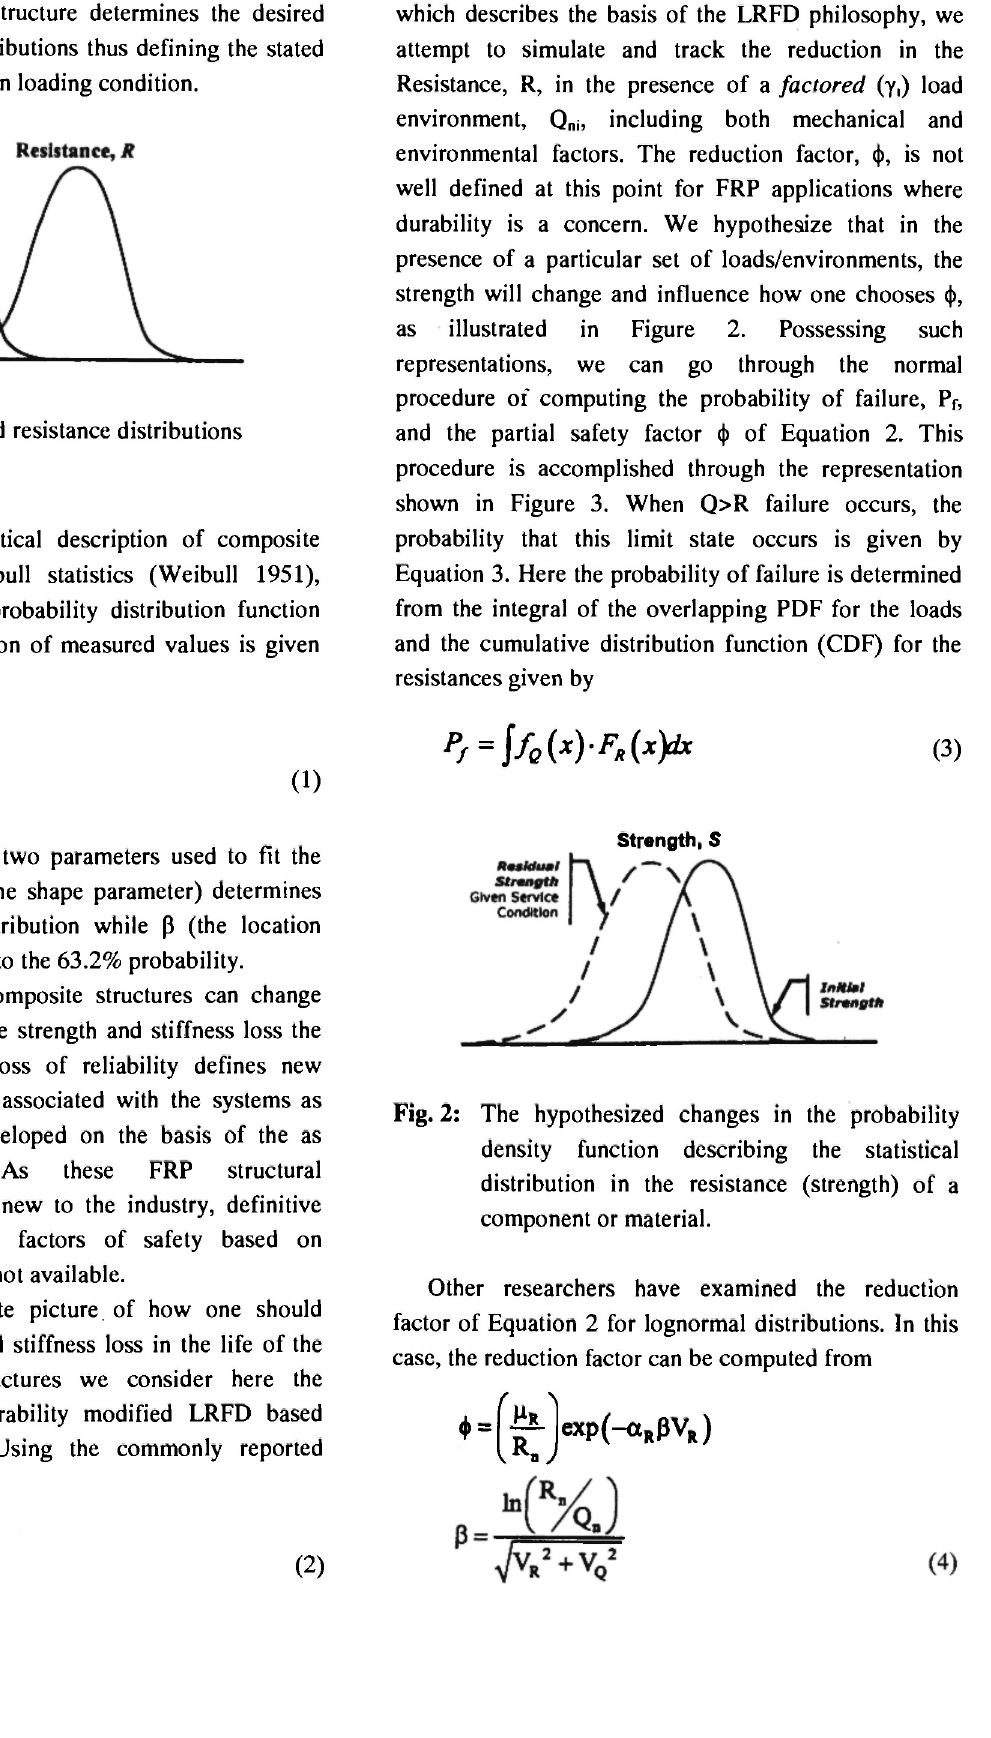
Fig. 1: Load and resistance distributions